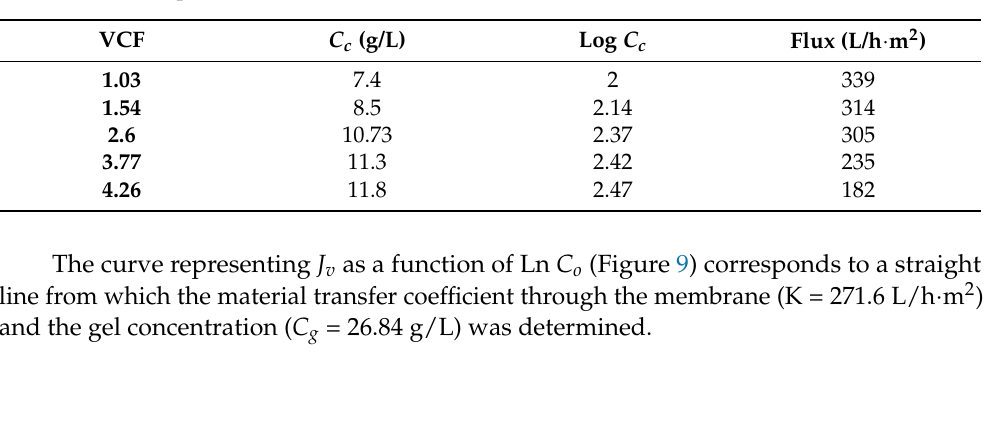
Table 7. Flux and protein concentration values in the concentrate for each VCF